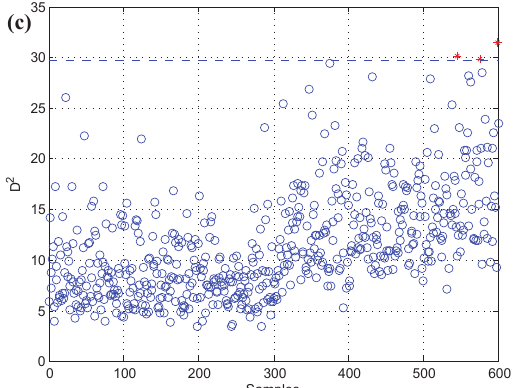
Figure 14. Fault detection result ( a ) after reconstructing variable 2, ( b ) after reconstructing variables 2 and 10, ( c ) after reconstructing variables 2, 10, and